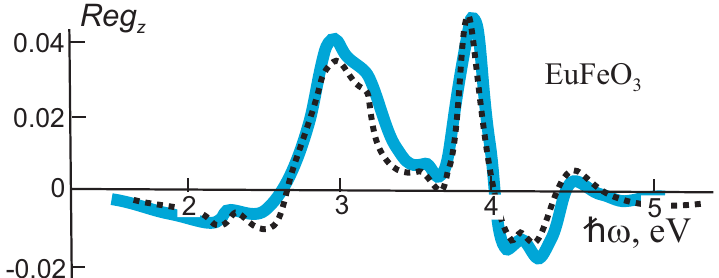
Figure 6. Spectral dependence of the real part of the z − component of the gyration vector in EuFeO 3 : experimental data are shown by the dotted curve; model fitting is shown by the solid curve. Adapted from